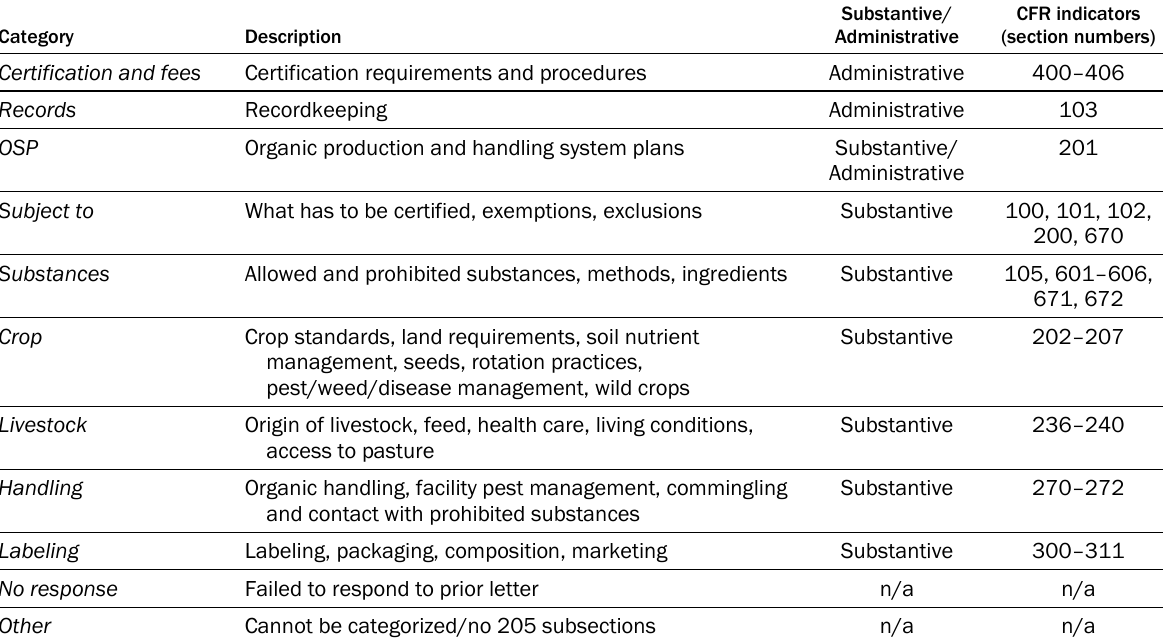
Table 1. Noncompliance Violation Codes, Descriptions, and